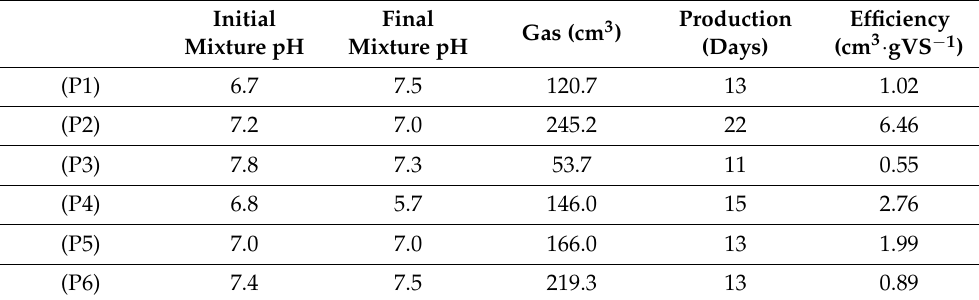
Table 4. Biogas production parameters and pH of test (P1–P6)